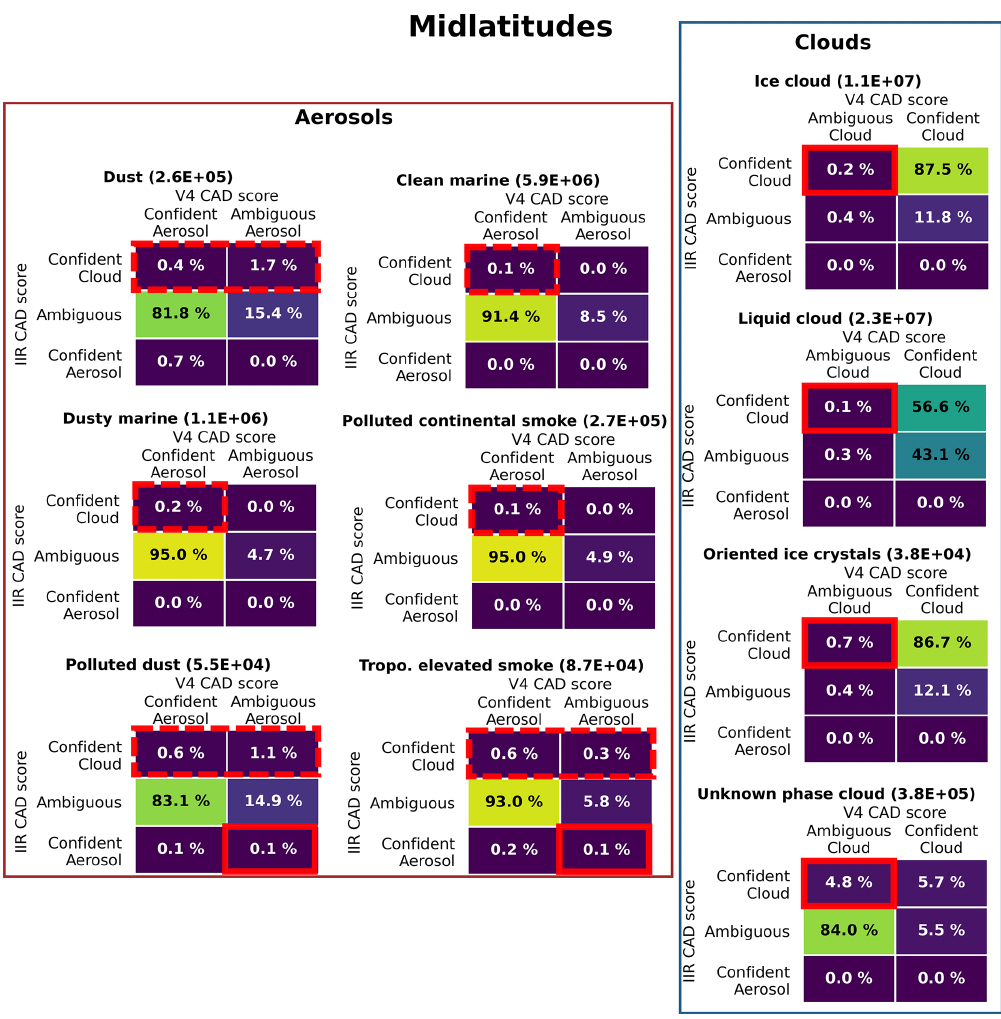
Figure 14. As Fig. 13 for the midlatitudes. Red rectangles show where the V4 CAD algorithm can benefit from IIR observations to confirm ambiguous clouds or aerosols (solid border line) and correct false aerosol detections (dashed border